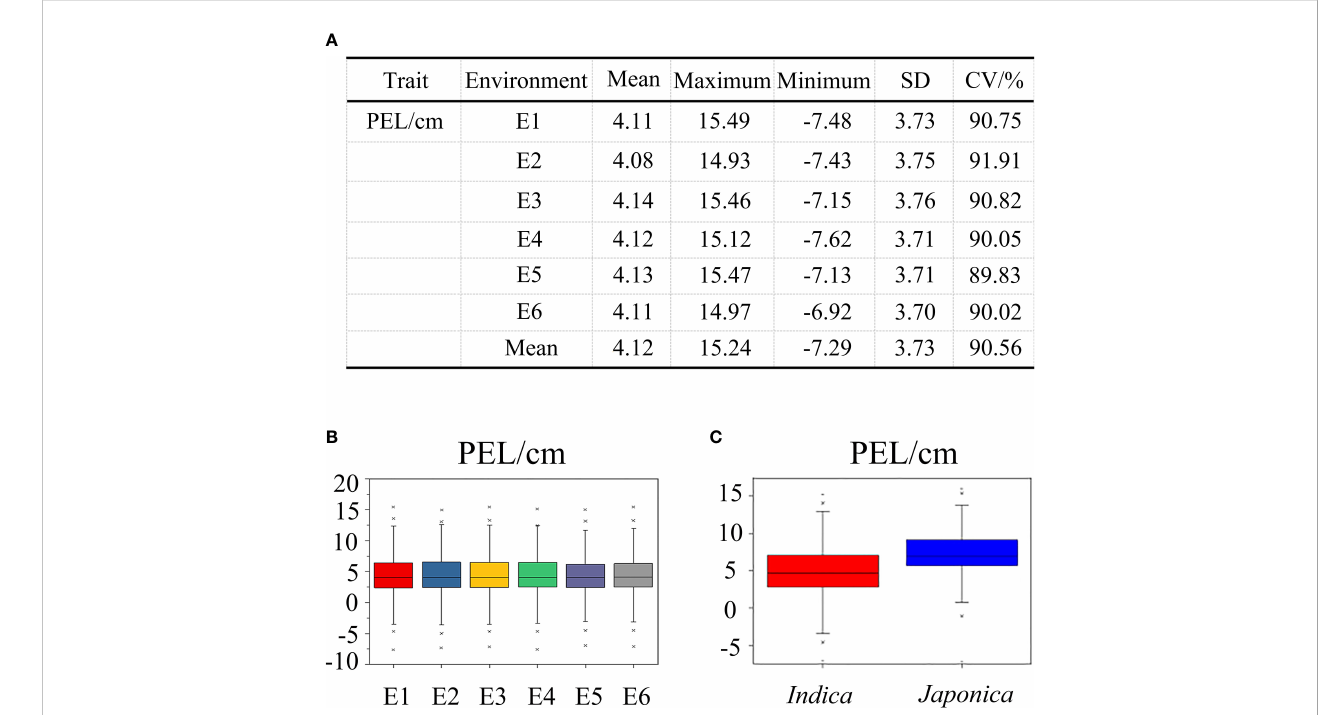
FIGURE 2 The phenotypic value description of PEL among 353 rice accessions at six environments. (A) Basic statistics of PEL in six environments. (B) Phenotypic value distributions in six environments. (C) Phenotypic value distributions of PEL in the indica and japonica subgroups. The box edges represent the upper and lower quantiles. The median value in black was shown in the middle of the box. Vertical lines represent the data from the lowest quantile to the top quantile. Asterisks indicate individuals falling outside the range of the